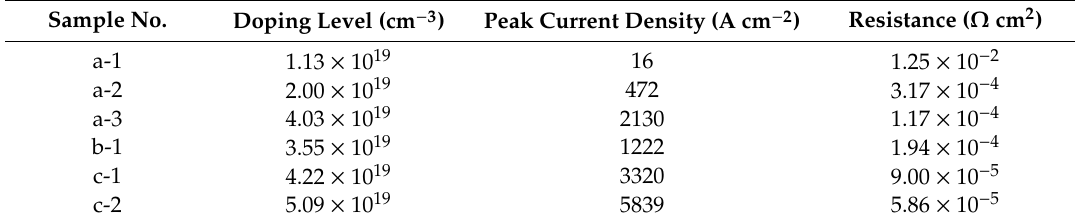
Table 2. Summary of experimental results.